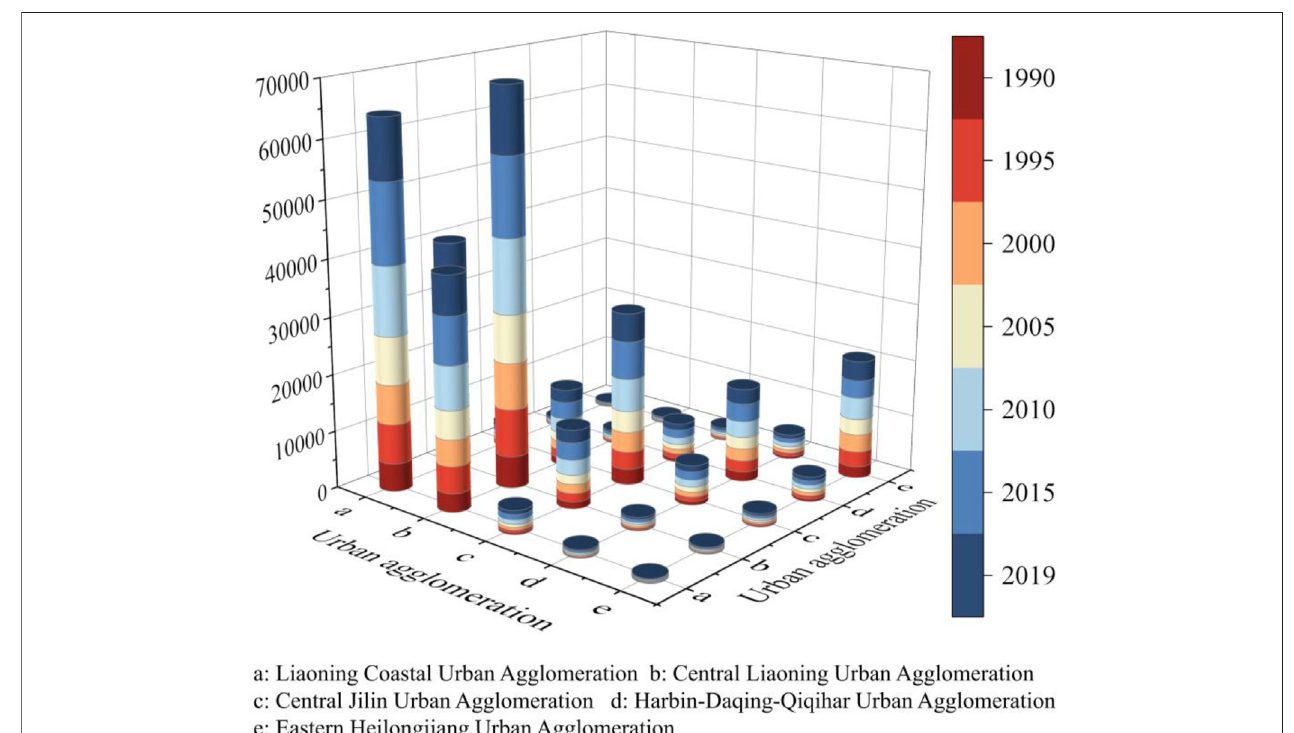
FIGURE 5 | Relevance coef fi cient matrix between urban